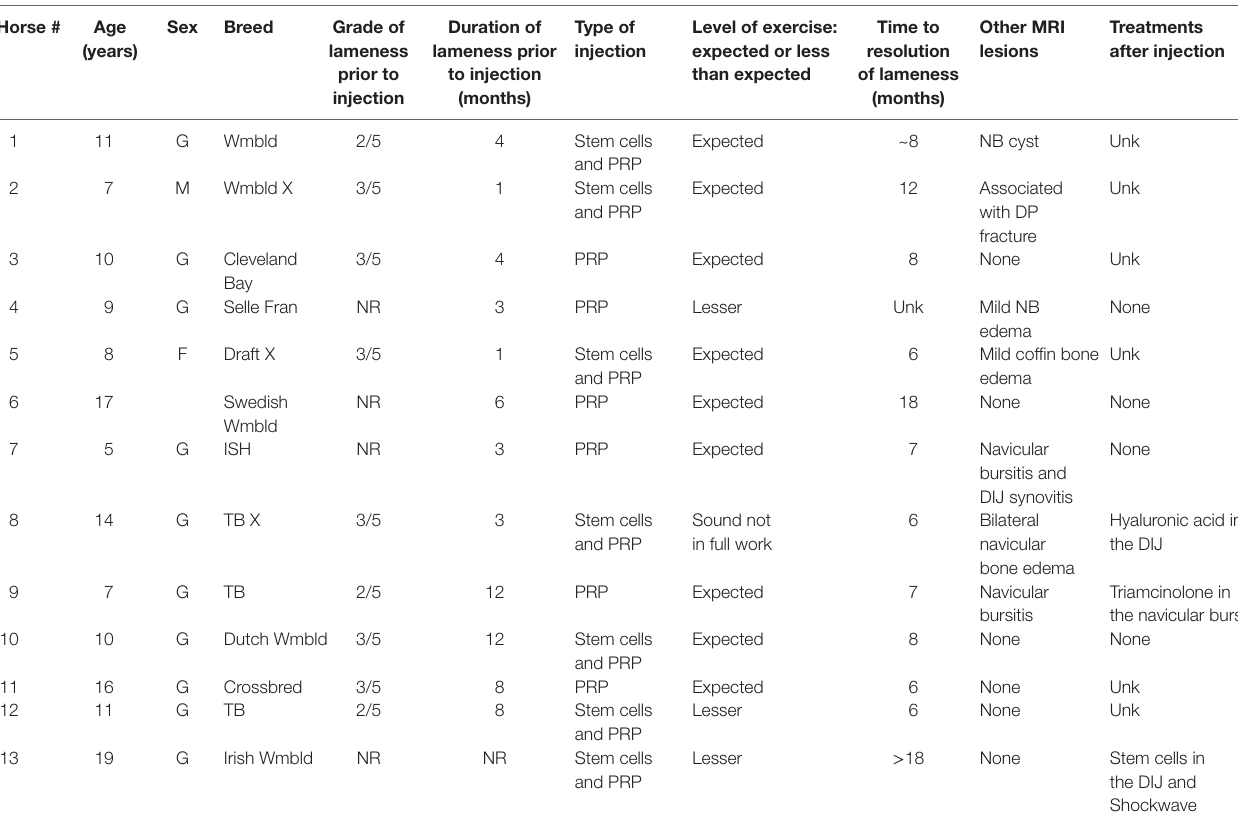
TaBle 1 | Mri-guided injection of the DiJcl. horse # age